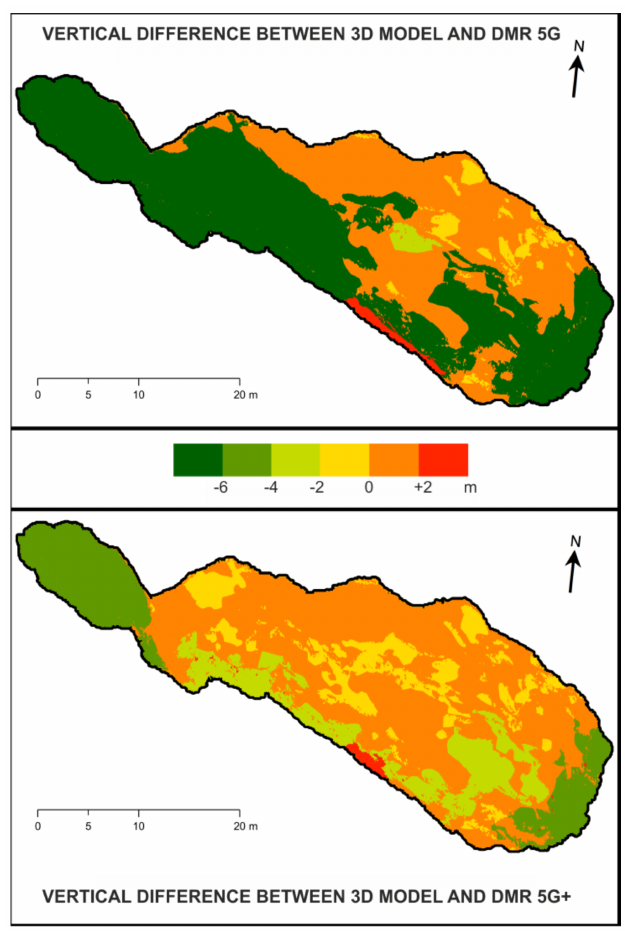
Figure 7. Demonstration of DMR 5G+ and DMR 5G variance at the B í l á sk á la location created from a 3D rock